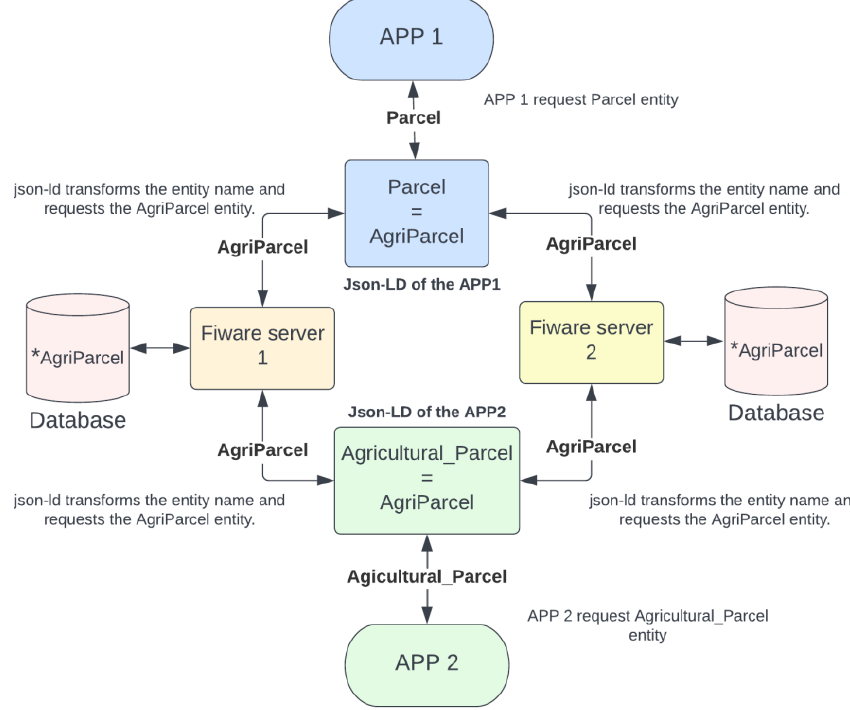
Figure 4. Simplified diagram of how JSON-LD works in FIWARE (with Orion-LD) using the “Agri- Parcel”